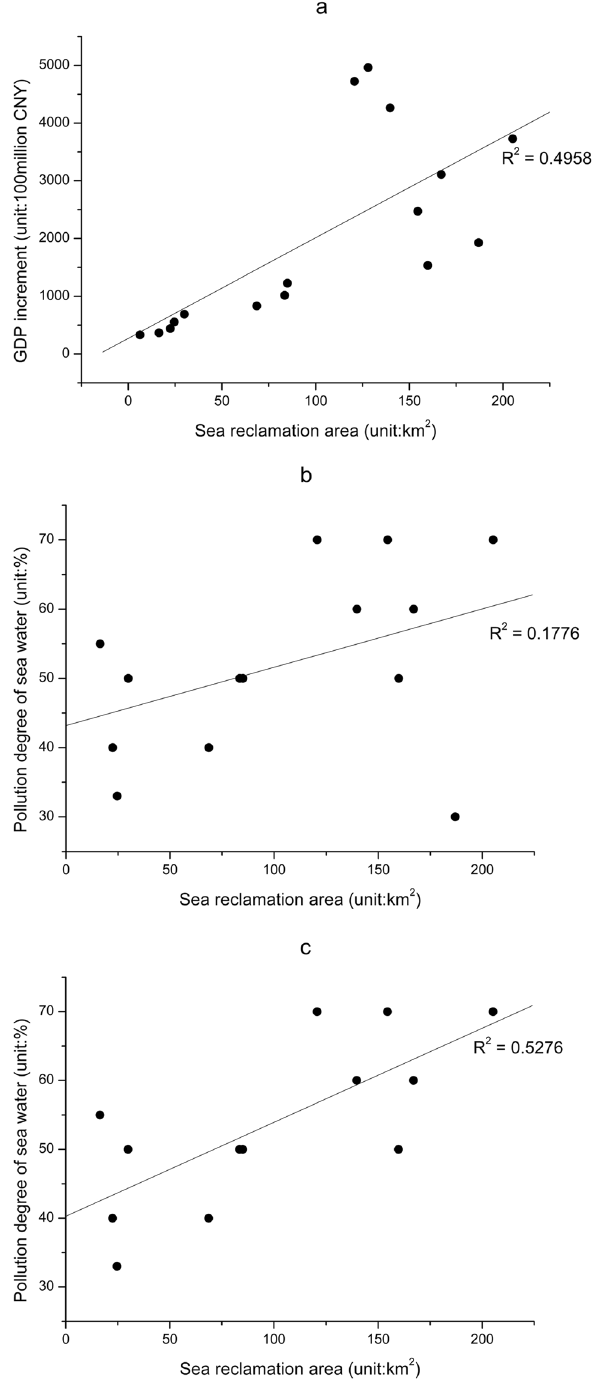
Figure 2. Scatter diagrams. ( a ) Coastal reclamation area and GDP growth, ( b ) Coastal reclamation area and pollution degree of sea water, and ( c ) Coastal reclamation area and pollution degree of sea water except for